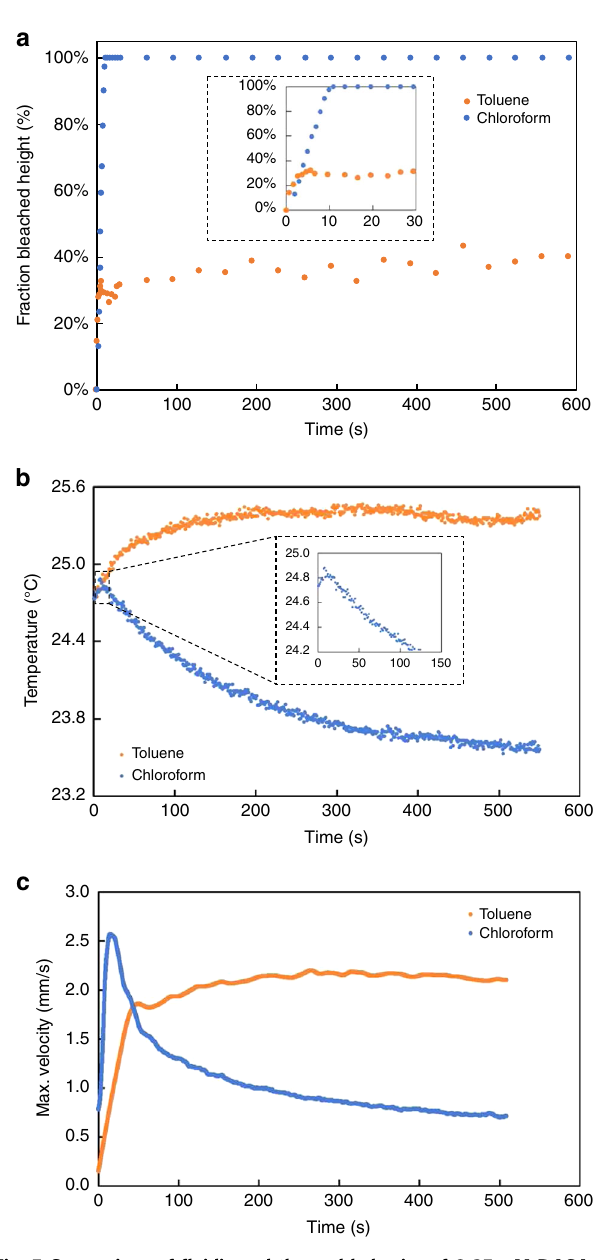
Fig. 5 Comparison of fl uidic and thermal behavior of 0.25 mM DASA in chloroform and toluene irradiated with 46 mW cm − 2 white light. a Percent of bleached volume (i.e., height of the bleach front / total wetted length) versus time. Inset depicts the same curves from 0 to 30 s. b Temperature changes over time for toluene and chloroform. Inset depicts the initial spike and then decline in temperature exhibited by DASA in chloroform. c Maximum velocity vs. time plots illustrate characteristic velocity trends. See Supplementary Note